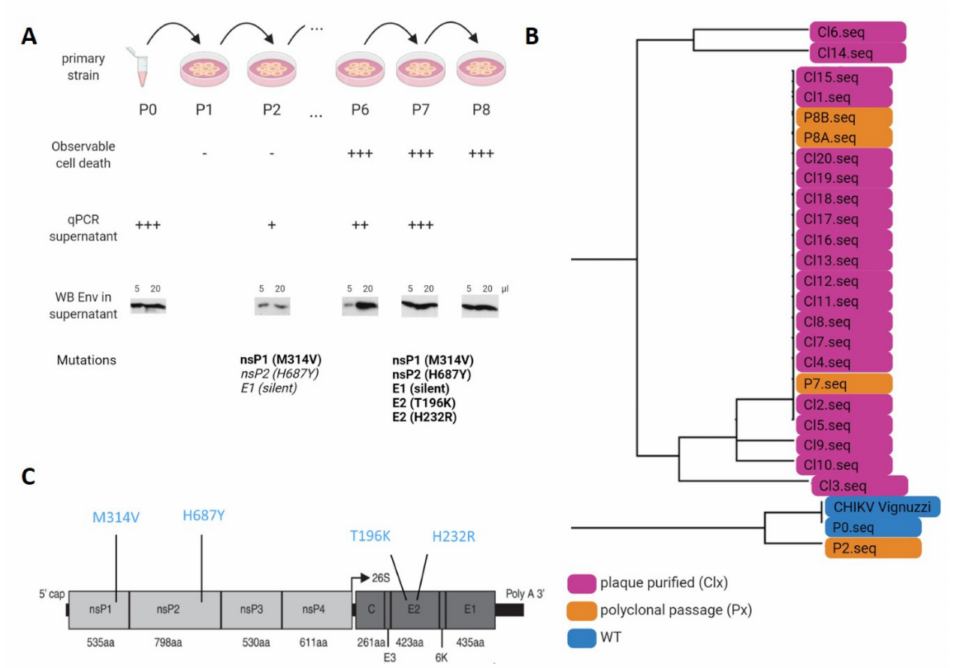
Figure 2. Serial passaging of CHIKV on A549 cells. ( A ) Serial passaging strategy used for adaptation of CHIKV (IOL) to A549 cells. The amount of cell death was monitored during this protocol. Viral RNA in cell-culture media was measured by RT-qPCR after P0, P2, P6, and P7. Increased presence of RNA genomes or cell death is indicated with “-“, “+”, “++” and “+++”. Viral envelope proteins were determined by western blot by loading 5 or 20 µ L of cell culture supernatant after P0, P2, P6, P7, and P8. Deep sequencing identified adaptive mutations in P0, P2, P7, and P8 stocks. Present mutations are indicated; mutations in italic are presented as a mixture. ( B ) Phylogenetic tree generated using Clustal W generated multiple sequence alignment of sequenced passages P0, P2, P7, and P8 and 20 plaque-purified monoclonal viruses from P8 ( C ) Location of mutations found in CHIKV after adaptation to A549